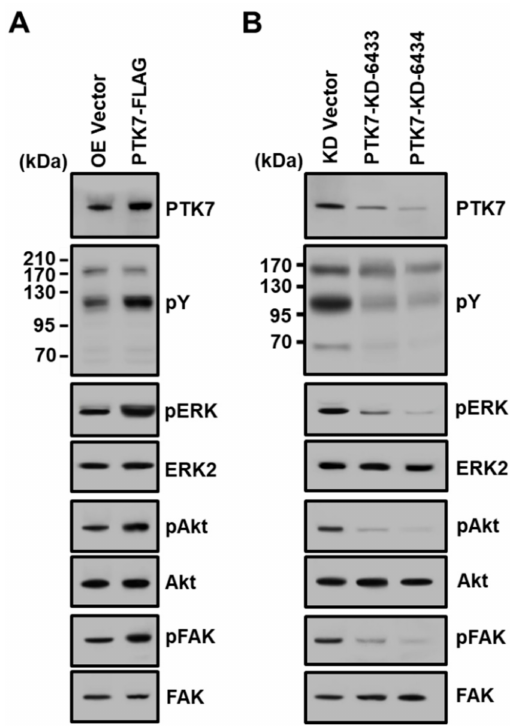
Figure 3. Effect of PTK7 overexpression and knockdown on activation of signaling molecules in ESCC KYSE-30 cells. Tyrosine phosphorylation of cellular proteins, as well as phosphorylation of ERK, AKT, and FAK, was examined by Western blotting in KYSE-30 cells infected with lentiviruses for vector control (OE Vector) and PTK7 overexpression (PTK7-FLAG) ( A ), as well as the vector control (KD Vector) and PTK7 knockdown shRNA (PTK7-KD-6433 and -6434) ( B